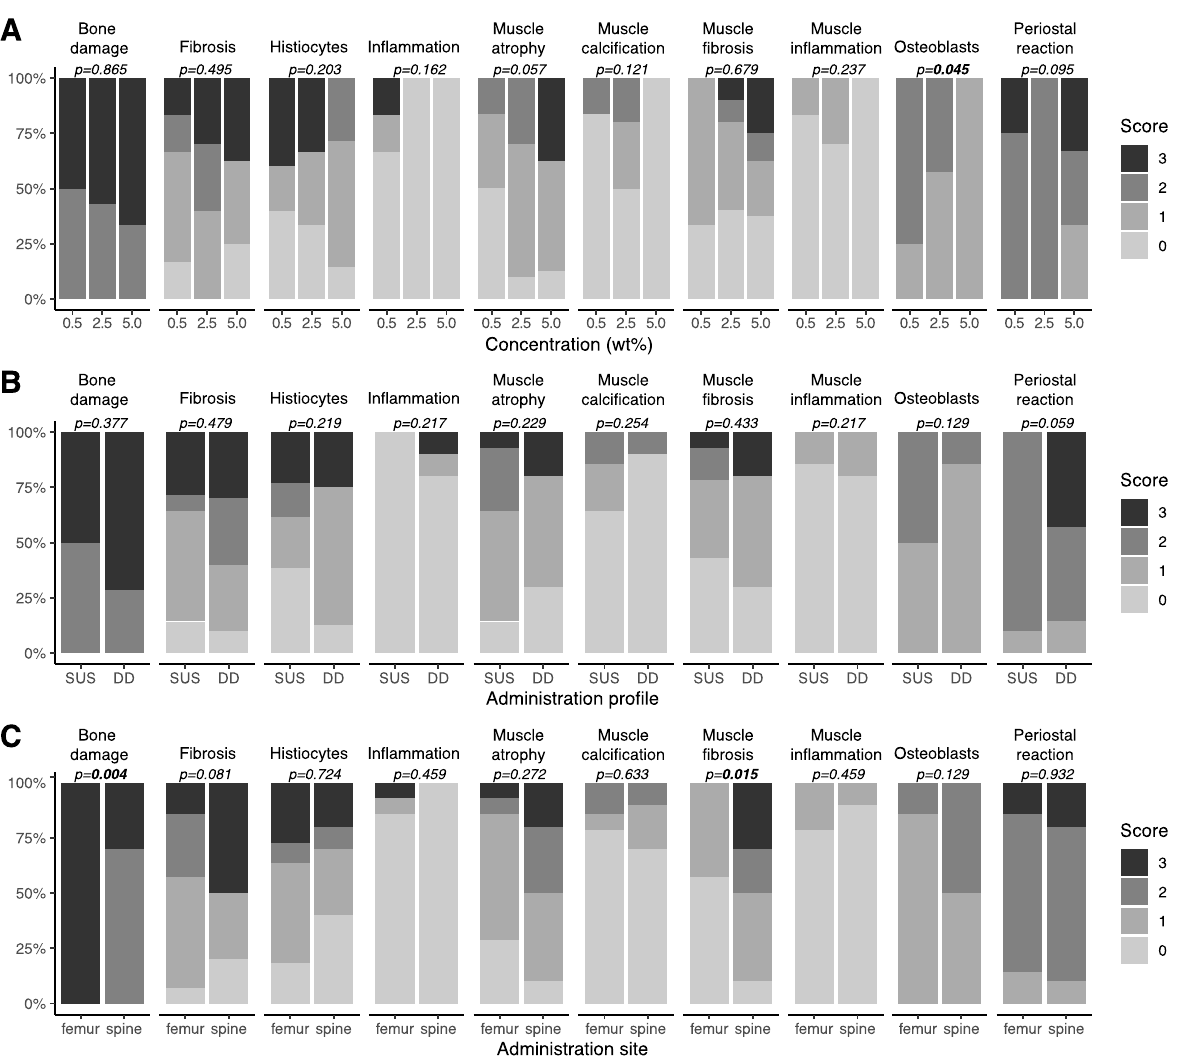
Fig. 3 Bar charts displaying the frequency of histology scores per histological parameter as a function of A ) bupivacaine concentration administered (wt%), B ) bupivacaine administration profile (SUS – Sustained administration, DD – Dose Dump administration) and C ) administration site (spine and femur). P ‑values obtained from Chi‑squared tests are displayed. In case of a significant Chi‑squared test and comparison between > 2 groups, a post‑hoc Bonferroni testing was